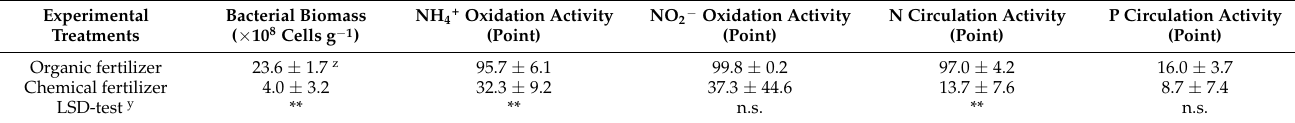
Table 4. Biological properties of soils of orchards under organic and chemical fertilizer management systems. Experimental Treatments Organic fertilizer